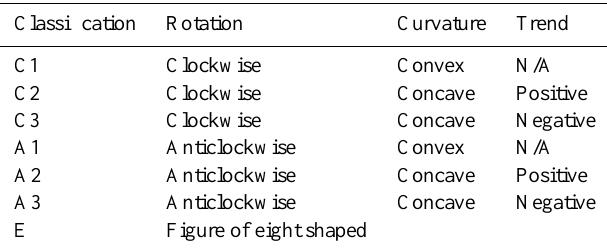
Table 2. Classification of concentration-discharge hysteresis loops after Evans and Davies